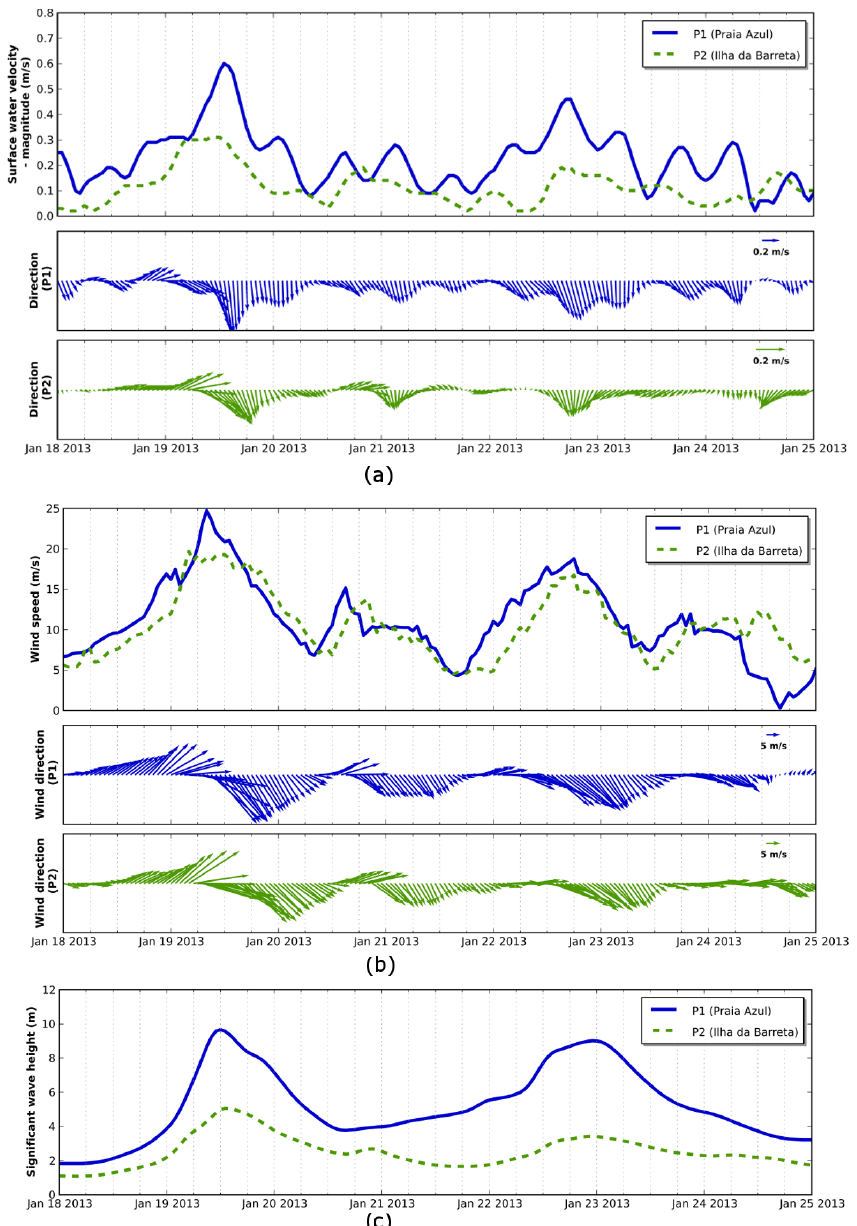
Figure 9. Metocean conditions used in the risk model, at points P 1 and P 2 , during January. Surface water velocity, wind velocity and significant wave